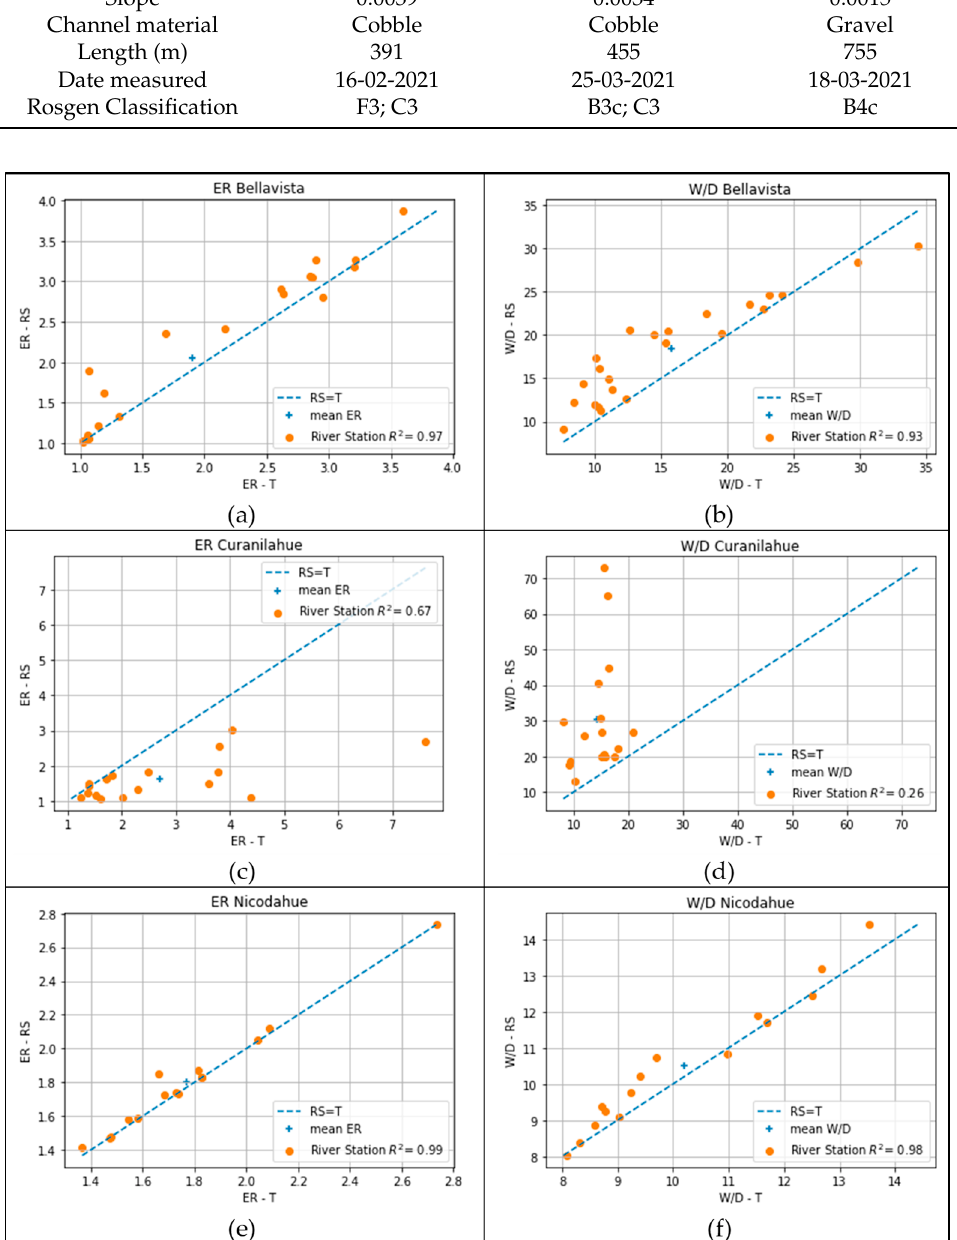
Figure 3. Comparison of entrenchment ratio (ER-T vs. ER-RS) and comparison of width/depth ratio (W/D-T vs. W/D-RS) for the Bellavista ( a , b ), Curanilahue ( c , d ), and Nicodahue rivers ( e , f ). The dashed blue line represents the 1:1 ratio of the RS to T results. R 2 as the coefficient of determination.